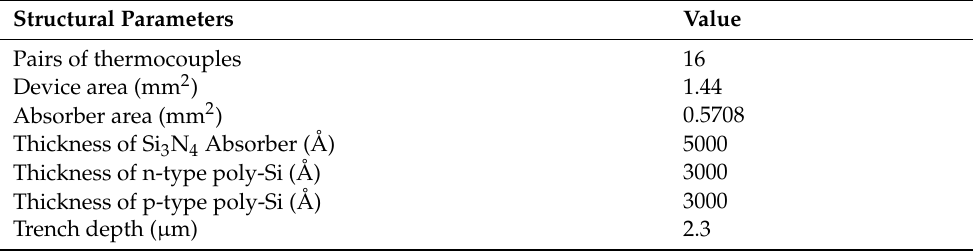
Figure 2. Schematic diagrams of ( a ) an MB-based thermopile, ( b ) a CM-based thermopile, ( c ) a group of thermocouples, and ( d ) a micro trench. Table 1. Structural parameters of the designed MB-based